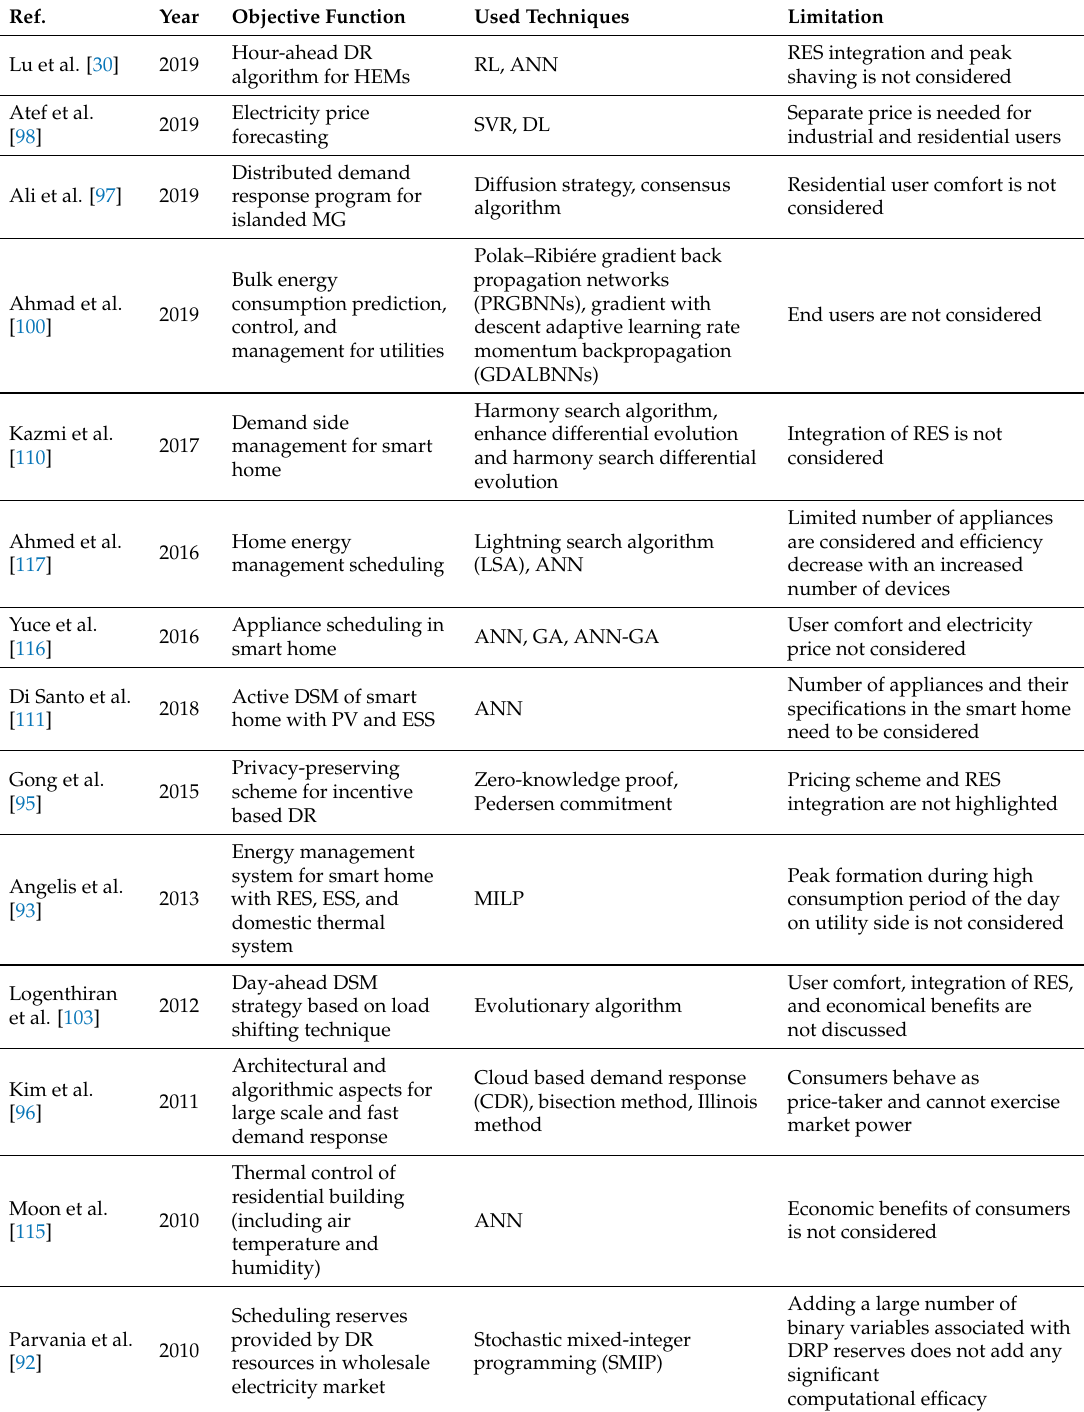
Table 4. AI techniques for demand response and the HEM